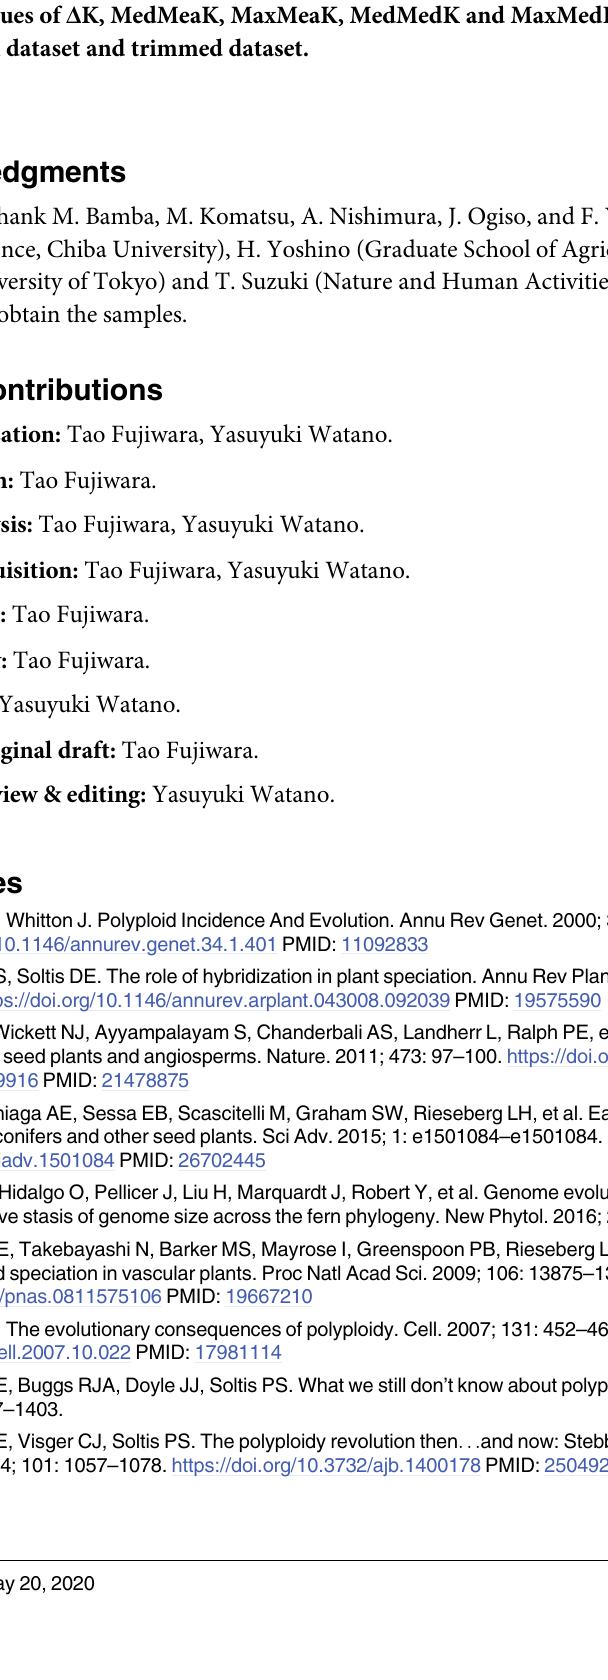
S5 Table. Values of Δ K, MedMeaK, MaxMeaK, MedMedK and MaxMedK for Instruct result for full dataset and trimmed